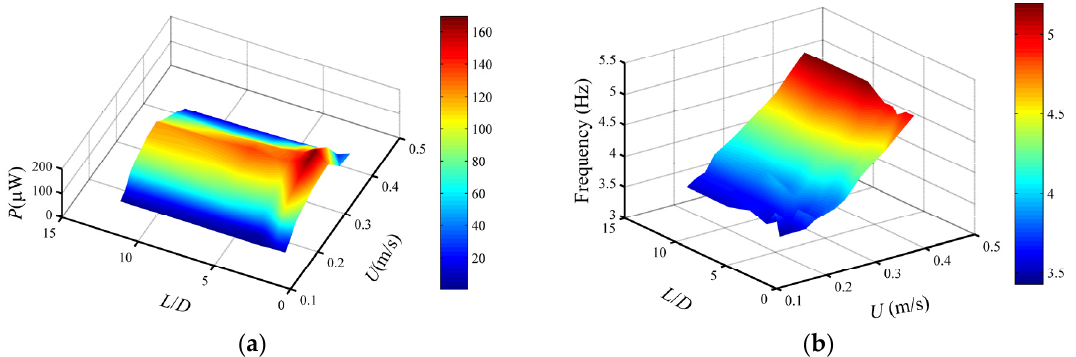
Figure 7. Variations of the output power and the frequency of vortex shedding from the upstream harvester, respectively, with the water speed and the spacing ratio: ( a ) Output power as a function of the water speed and the spacing ratio; ( b ) Frequency of vortex shedding from the upstream harvester as a function of the water speed and the spacing ratio.